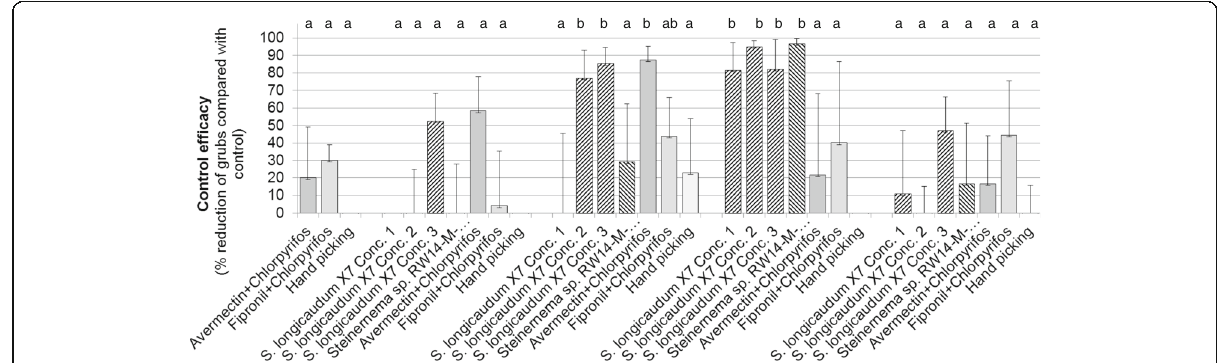
Fig. 4 Efficacy of entomopathogenic nematodes, insecticide tuber coatings and handpicking at reducing Anomala and Hoplochelus white grub numbers depending on time periods. EPN concentration 1 = 0.75 × 10 9 infective juveniles (IJs)/ha; concentration 2 = 1.5 × 10 9 IJs/ha; concentration 3 = 2.5 × 10 9 IJs/ha. Field M in Musanze and field N in Nyamagabe districts in Rwanda in 2015. Four plots per treatment per field. Different letters on bars indicate differences among different treatments at p < 0.05 according to multiple comparison Tukey post hoc range test after GLM. Error bars =